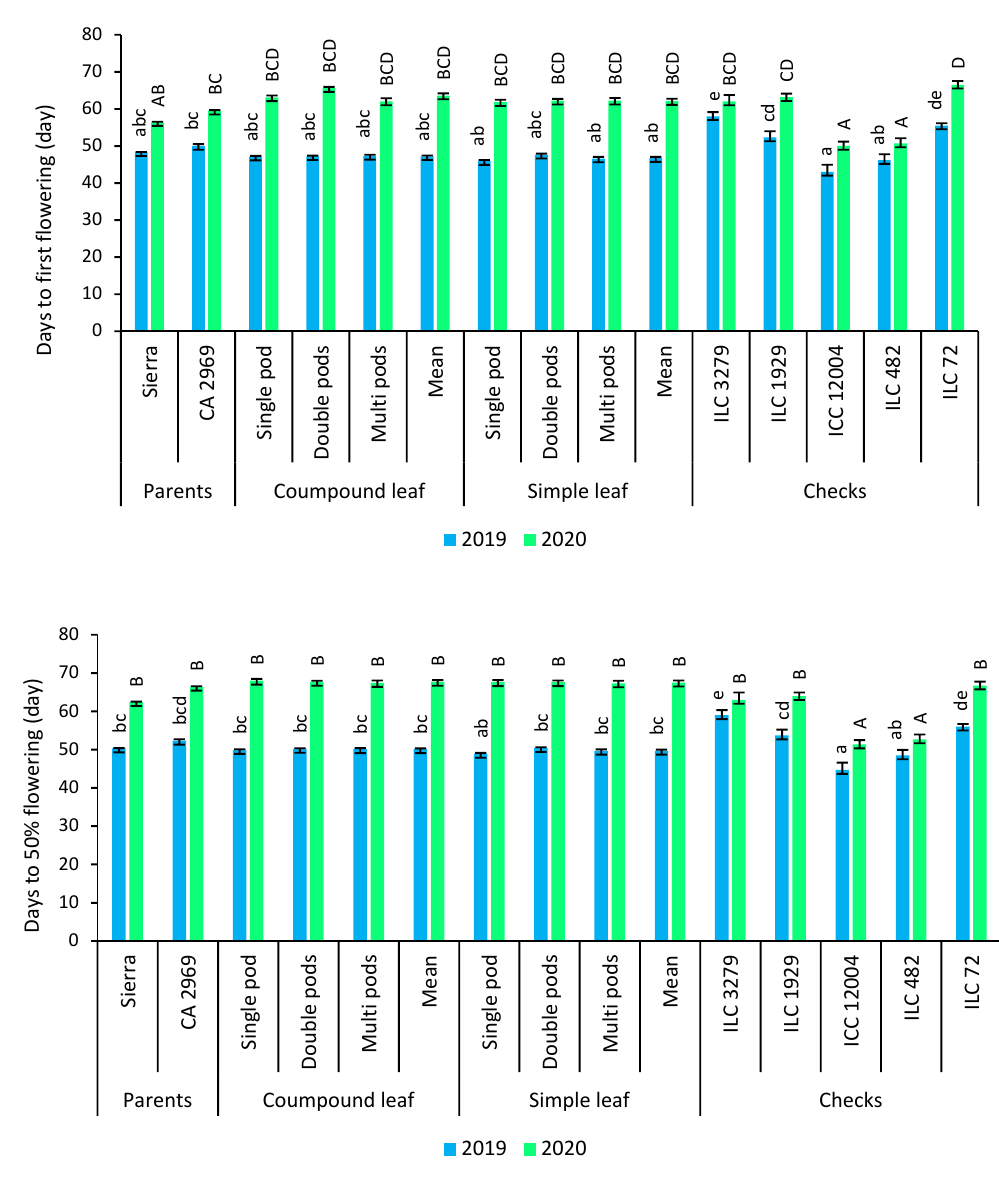
Figure 3. Comparison of compound-leafed versus simple-leafed and multi-podded versus double- podded and single-podded chickpeas with parents and checks for phenological traits. Different lowercase letters and uppercase letters represent the significant difference ( p ≤ 0.05) between the means for 2019 and 2020, respectively.